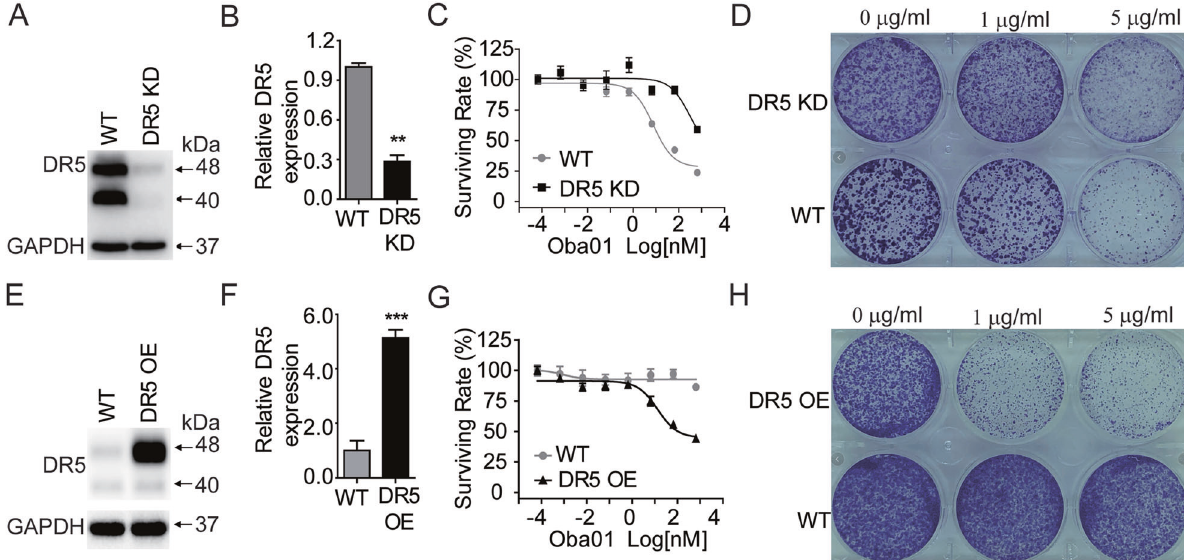
Fig. 2 Effects of DR5 knockdown (KD) and overexpression (OE) in PC cells on sensitivity to Oba01. A , B Protein and mRNA expression of DR5 in Mia PaCa-2 control and CRISPRi DR5 KD Mia PaCa-2 cells. C Cytotoxicity assay of Oba01 on Mia PaCa-2 control and DR5 KD cells. D Representative images of the clonogenicity assay in Mia PaCa-2 control and DR5 KD cells treated with Oba01. E , F DR5 protein and mRNA expression in T24 control and DR5 OE cells. G Cytotoxicity assay of Oba01 on T24 control and DR5 OE cells. H Representative images of the clonogenicity assay in T24 control and DR5 OE cells treated with